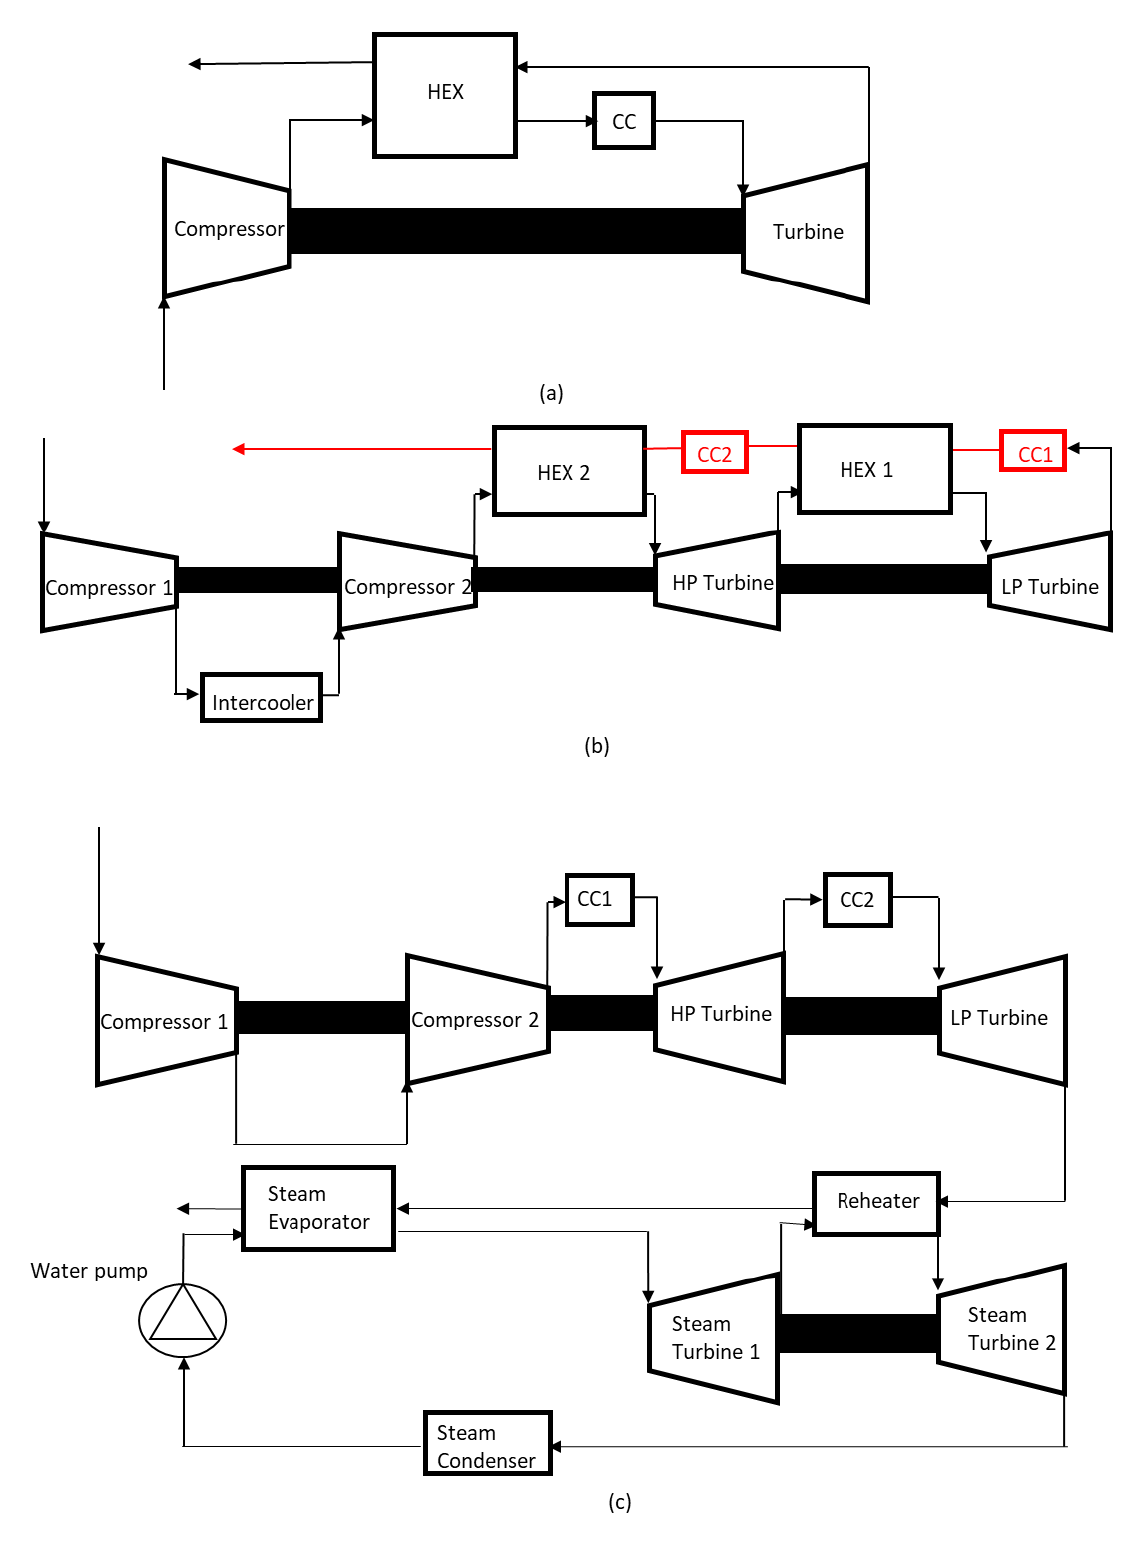
Figure 5. GT configurations from the literature: ( a ) Recuperated GT cycle, ( b ) Downstream-intercooled reheat external combustion GT cycle, ( c ) Reheat GT coupled to a turbine Reheat Steam Rankine cycle.